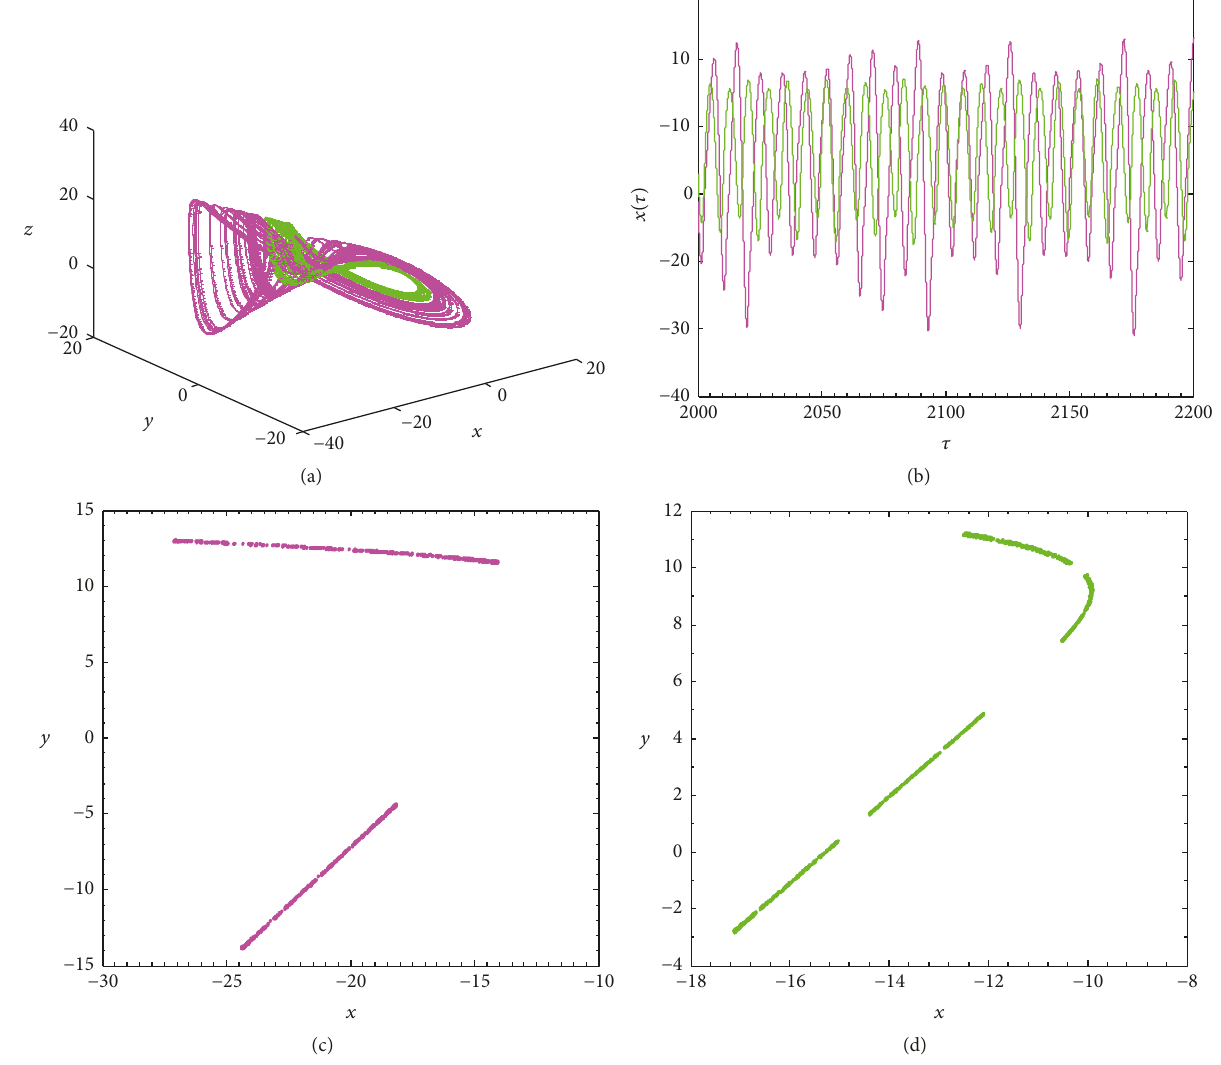
Figure 7: Three-dimensional view of the attractor projected onto the (𝑥,𝑦,𝑧) space of the system showing the coexistence of single-band chaotic attractor (attractor (screw-like Shilnikov) a(i) in magenta with a different single-band chaotic attractor (spiralling-like Feigenbaum) a(ii) in green color. (b) is the corresponding time traces of the coordinate 𝑥(𝜏) ) for a(i) in magenta and a(ii) in green. (c) is the corresponding single-sided Poincar´e section in the plane 𝑧 = 0 for a(i). (d) is the corresponding single-sided Poincar´e section in the plane 𝑧 = 0 for